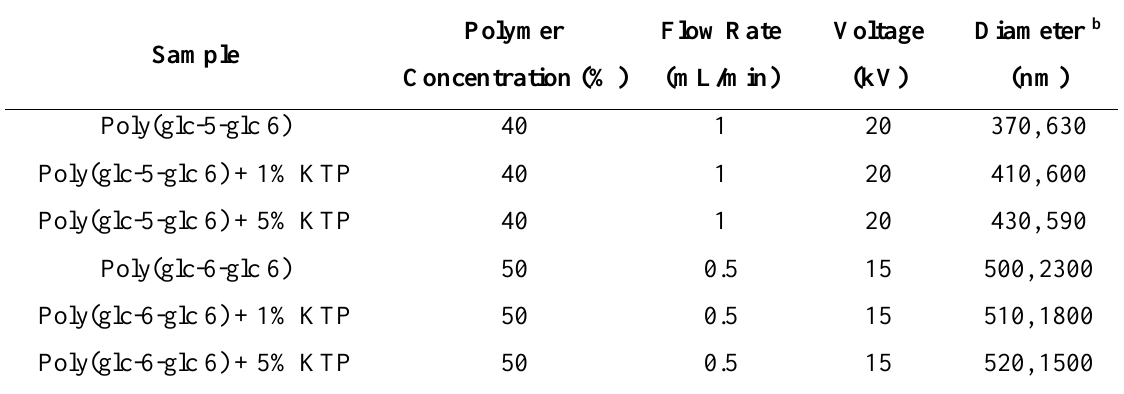
Table 1. Optimal conditions and diameters of unloaded and drug loaded electrospun PEA fibers a